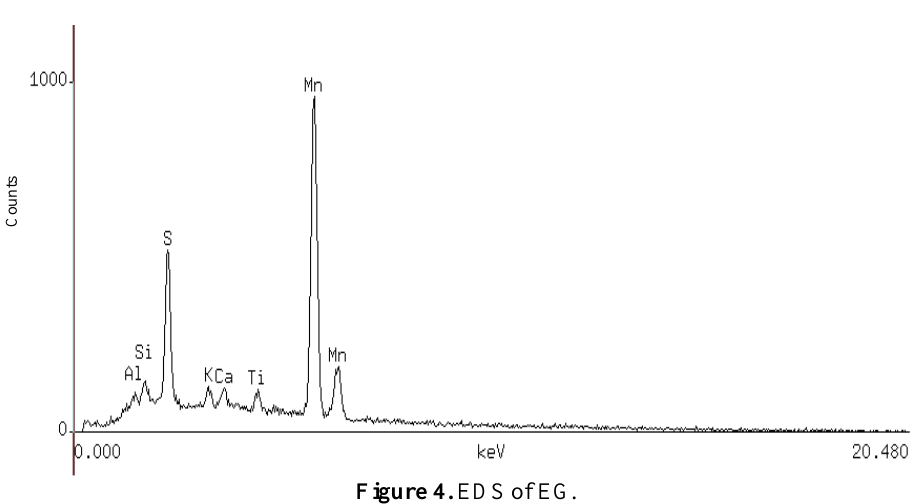
Figure 4. EDS of